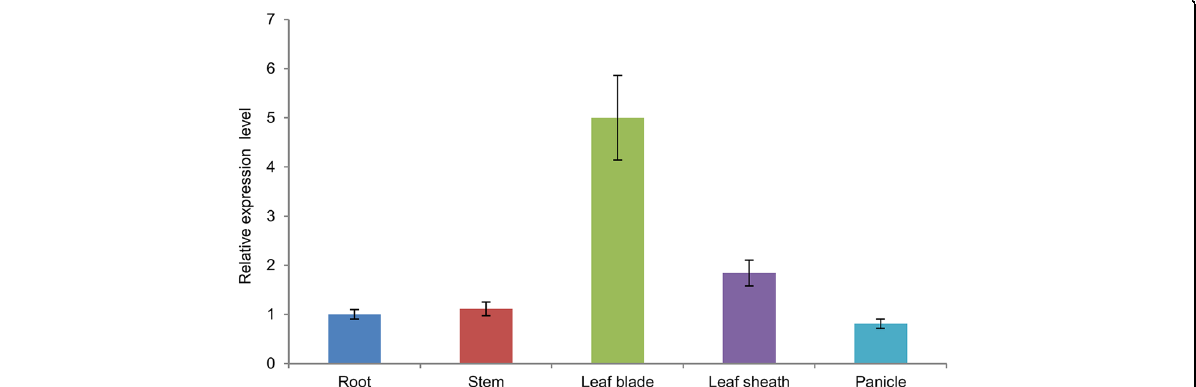
Fig. 7 Relative WGL2 transcript levels in various organs of WT plants. The WGL2 transcript levels in the roots were set to 1. Values represent the